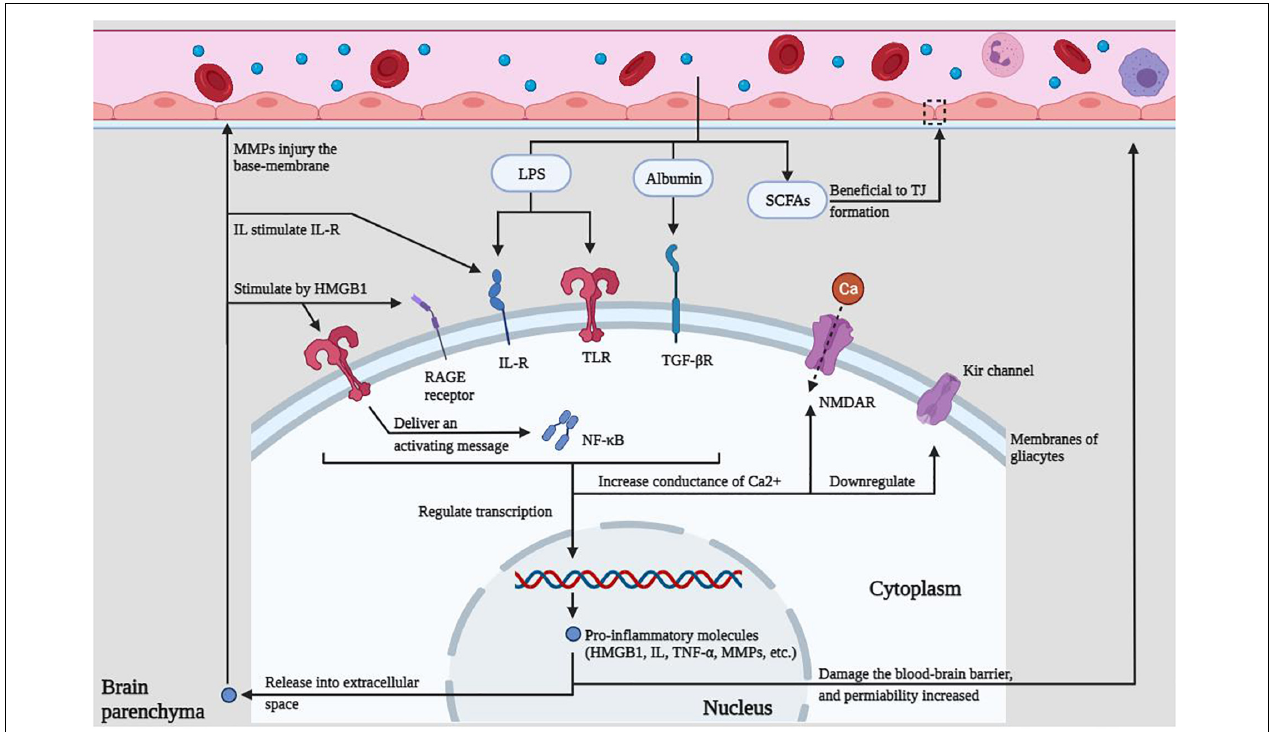
FIGURE 2 | Innate immune regulation within the CNS. LPS, albumin, and SCFAs in the peripheral circulation can act on various receptors, resulting in increased calcium conductance, down-regulated potassium channels, promotion of intracellular transcription, and release of immune molecules to cause BBB damage, which in turn lowers the seizure threshold or promotes epileptiform discharges, which eventually lead to